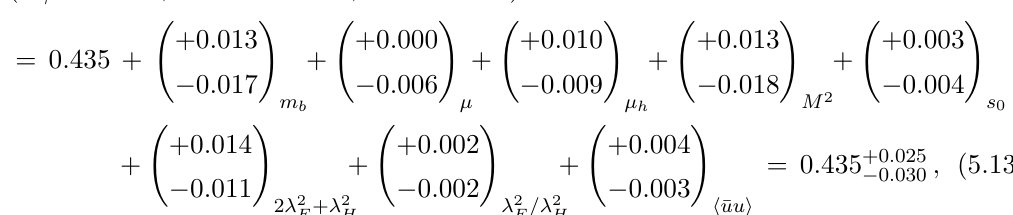
F ( E = 2 GeV ; (cid:21) (cid:13) V